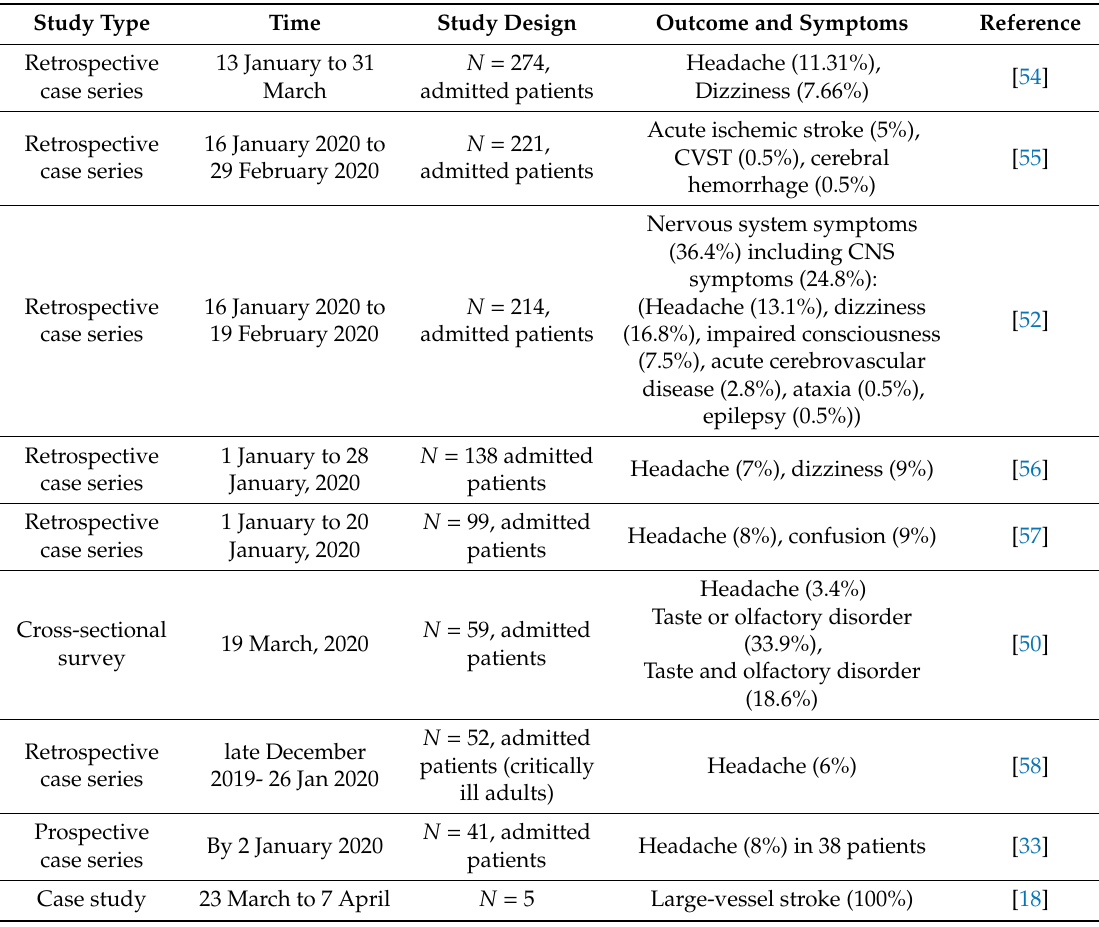
Table 1. Case studies on neurological and cerebrovascular symptoms in COVID-19